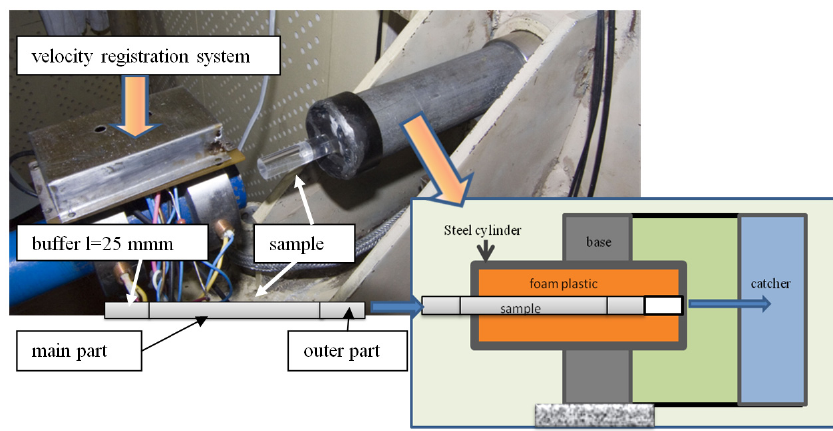
Figure 6: Ballistic set-up and scheme of steel cylinder with a sample.